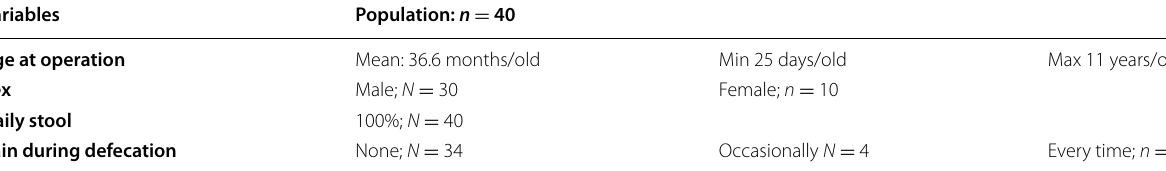
Table 1 The descriptive analysis of the studied patients